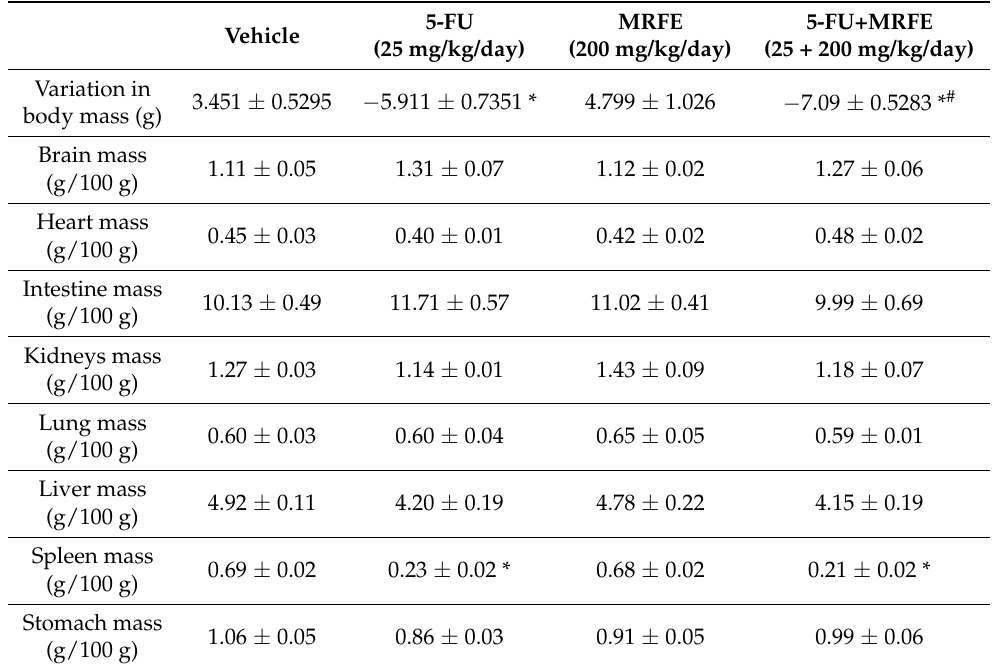
Table 2. Effect of 5-FU associated with MRFE 200 mg/kg/day on body and visceral mass variation in animals transplanted with sarcoma